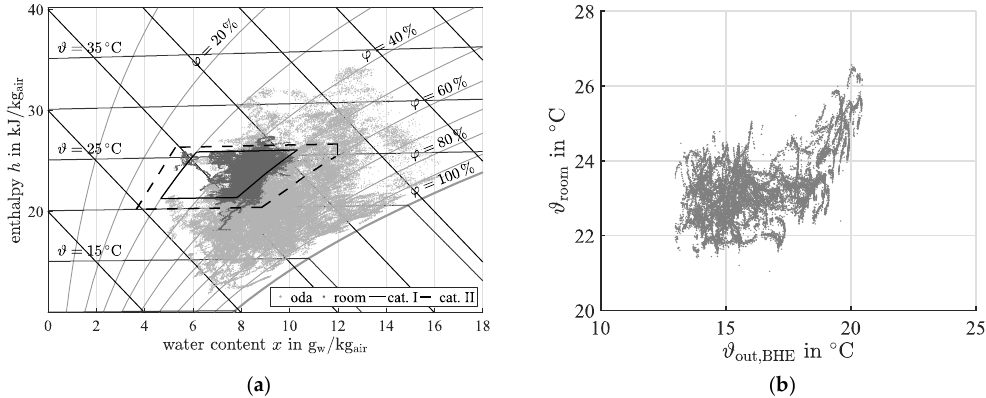
Figure 9. ( a ) Outside and room air conditions during system operation for the investigated cooling period; ( b ) dependence of room air temperature on BHE outlet temperature.